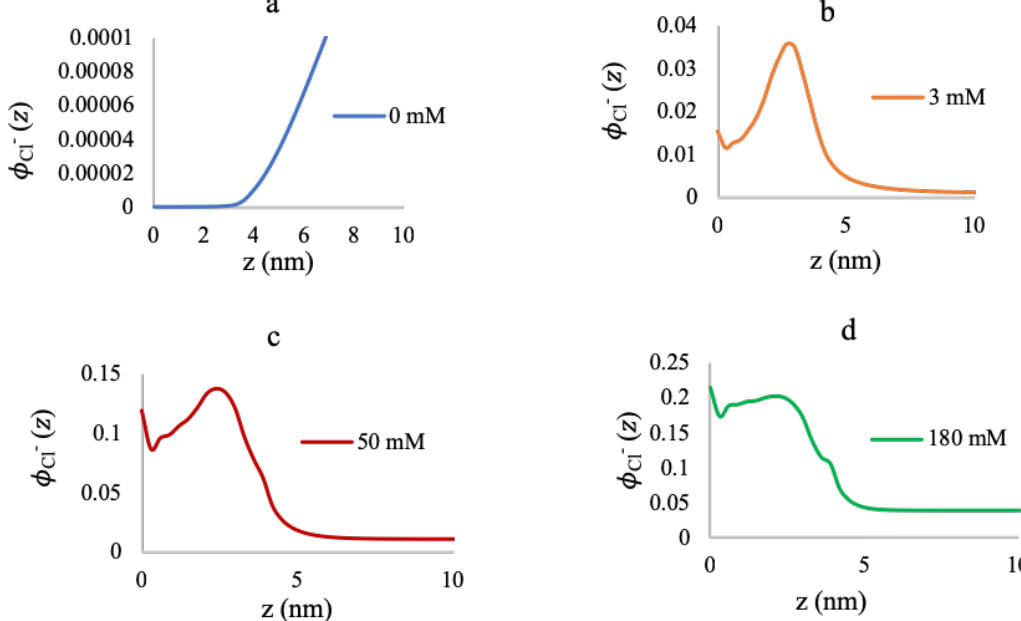
Figure 8. Chloride volume fractions at 0.5 chains/nm 2 for 0 mM ( a ), 3 mM ( b ), 50 mM ( c ), and 180 mM ( d ) MgCl 2